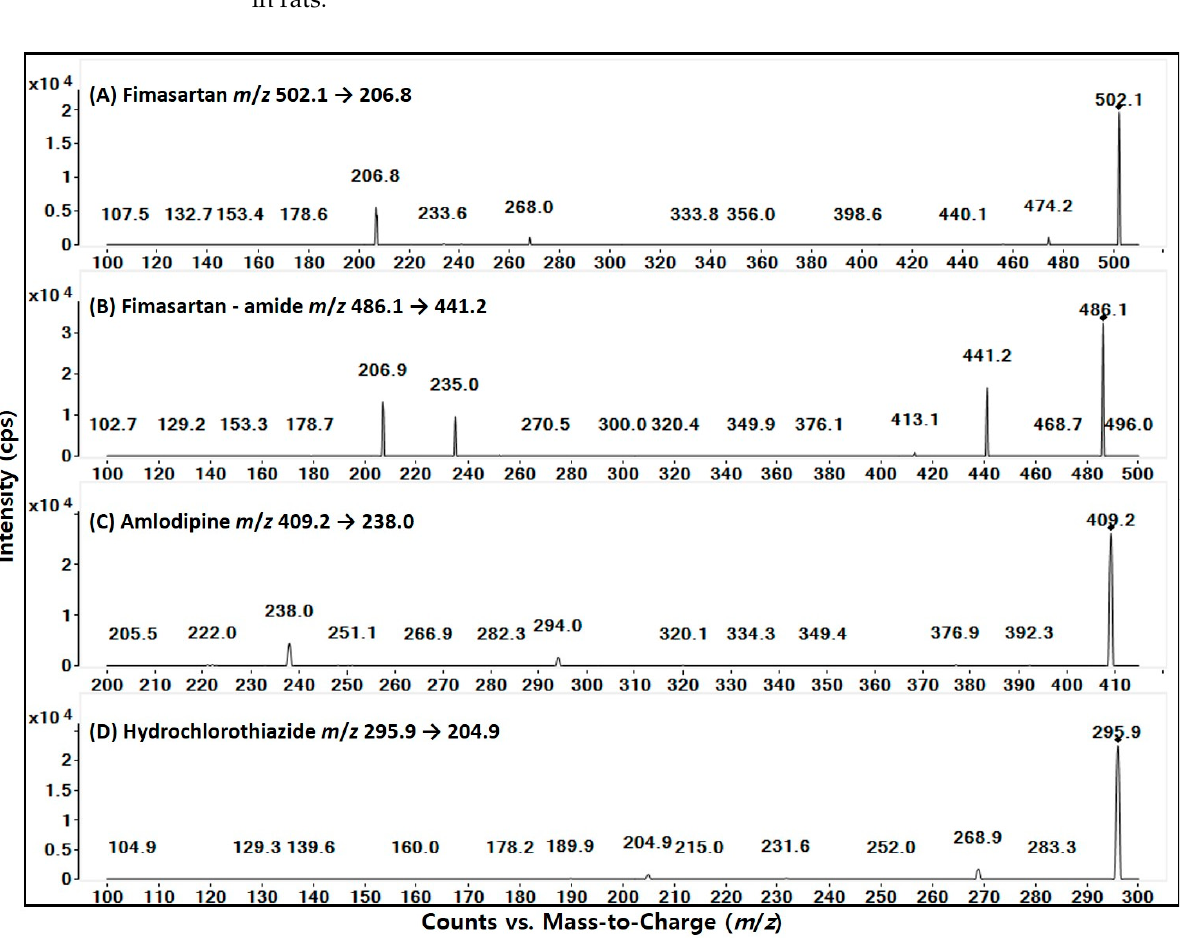
Figure 1. Structure and product ion mass spectra of ( A ) fimasartan, ( B ) fimasartan-amide, ( C ) am- lodipine, and ( D ) hydrochlorothiazide.